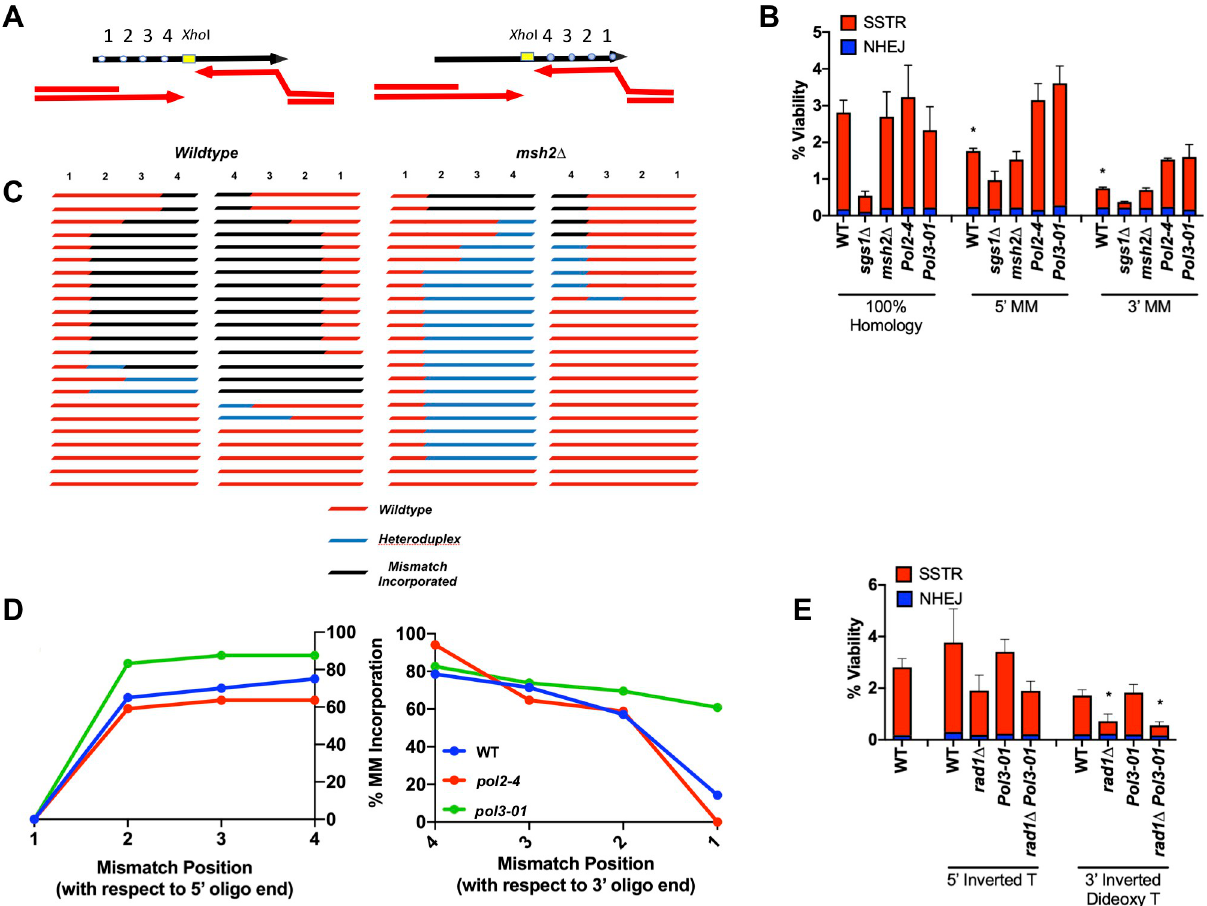
Fig 6. Gene editing events are dependent on the activity of MSH2. A) Experimental set-up to determine the effect of mismatches on SSTR. Mismatches are spaced every 9 nt from the Xho I site in the center of the template. Mismatch 1 is located only 2 nt from the terminus of the ssODN. SSTR events are determined by incorporation of an Xho I restriction site. B) Significance determined using an unpaired t-test compared to WT of the same template, � p � 0.01. n = 3. C) Inheritance of mismatches in wild-type (left) and msh2 Δ (right) strains. The inheritance of markers was determined separately by sequencing SSTR survivors using ssODNs with mismatches 5’ or 3’ of the Xho I site. The different outcomes were grouped together for comparison. D) Sequencing n = 23 per template per genetic background. E) Viability test of cells ability to survive DSB repair via SSTR with a template containing a chemical modification on the terminus of the ssODN. Significance determined using an unpaired t-test with wild-type levels using a template that does not have chemically modified ends, � p � 0.01. Error bars refer to standard error of the mean. n =